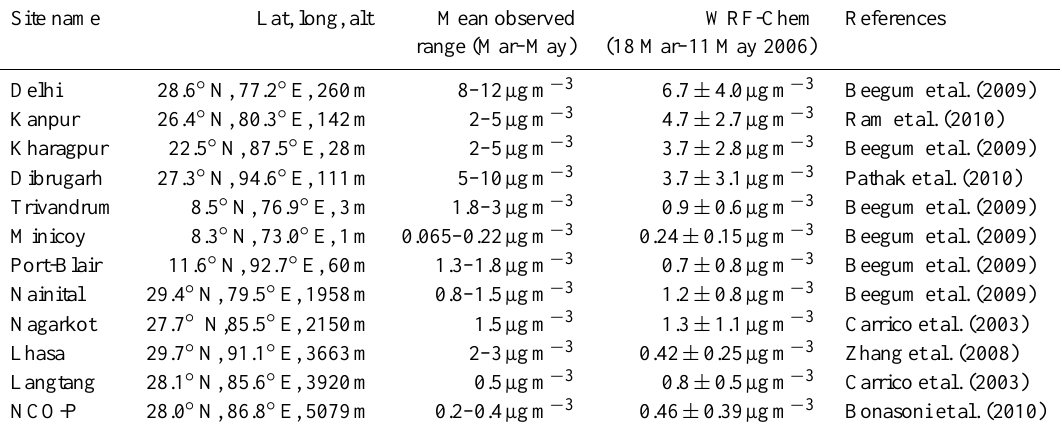
Table 1. WRF-Chem simulated BC mass concentration (mean ± standard deviation) averaged over the period of 18 March to 11 May 2006, and observed range of average values during March–May at nine inland stations located in the model domain. The observed BC values are taken from the papers listed in the reference column.